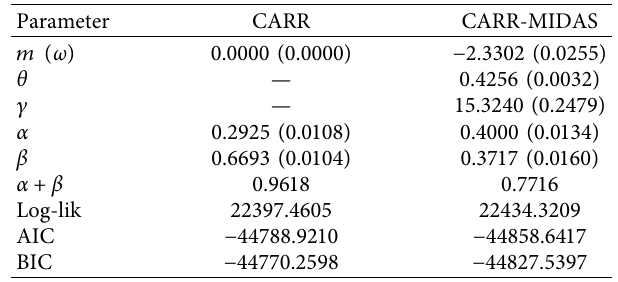
Table 2: Estimation